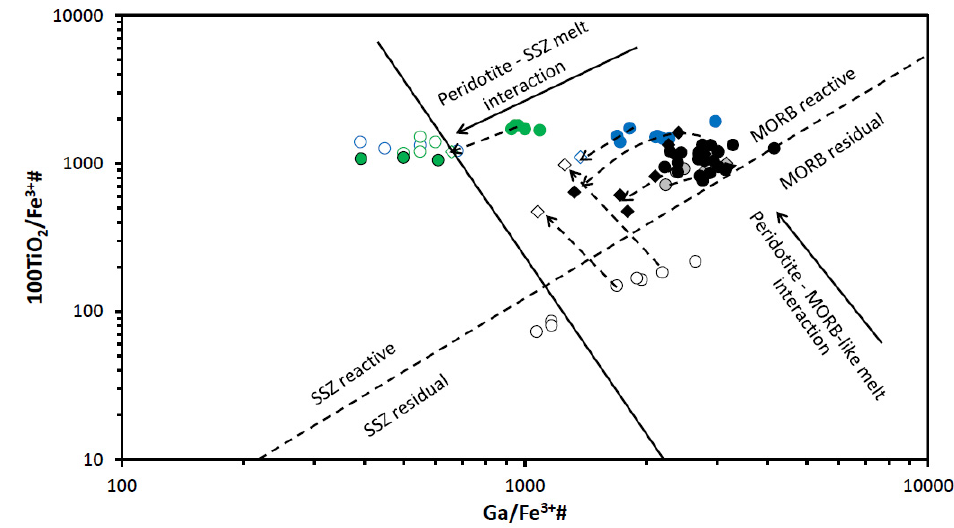
Figure 15. Diagram Ga/Fe 3+ # vs. 100TiO 2 /Fe 3+ # for spinels from the East Antarctic peridotite xenoliths. Fields for mid-ocean ridge basalt (MORB) residual, MORB reactive, suprasubduction zone (SSZ) residual and SSZ reactive peridotites and “Peridotite–MORB-like melt interaction“ trend and “Peridotite–SSZ melt interaction“ trend are after [27,28]. Symbols are as in Figure 9.